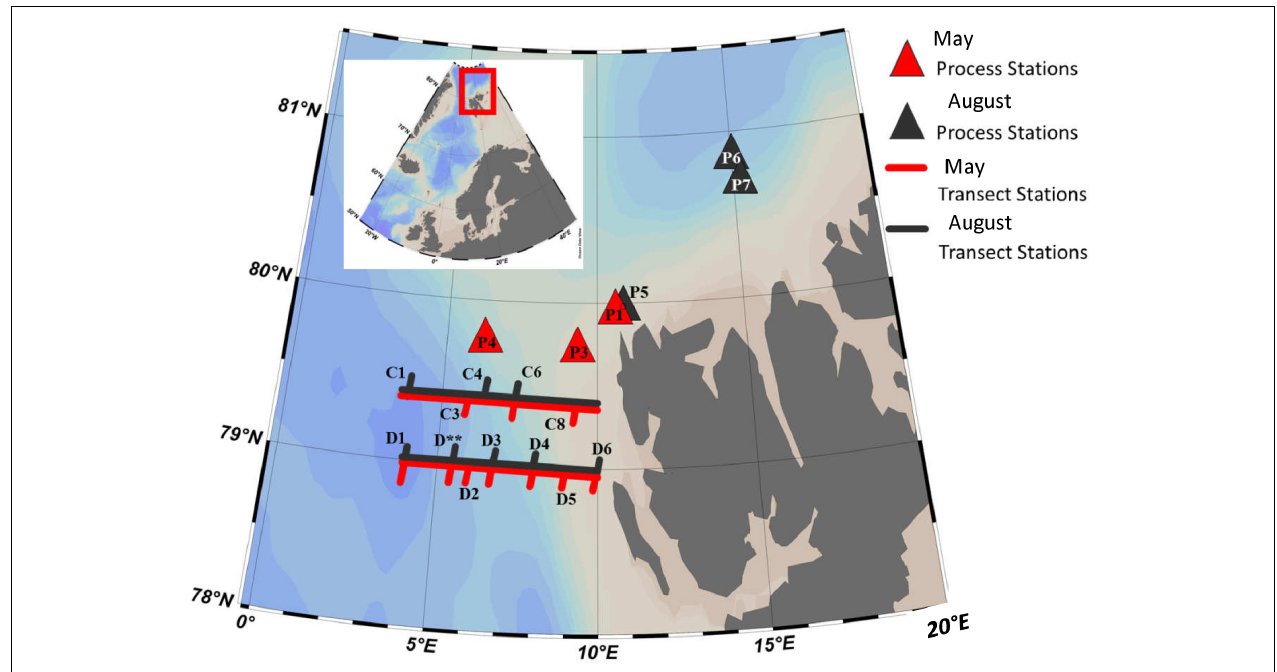
FIGURE 1 | The study sites in the eastern Fram Strait and the Arctic Ocean during the May and August Carbon Bridge cruises in 2014. TABLE 1 | Abiotic conditions at the process stations and phytoplankton growth and grazing mortality rates in May and August 2014.